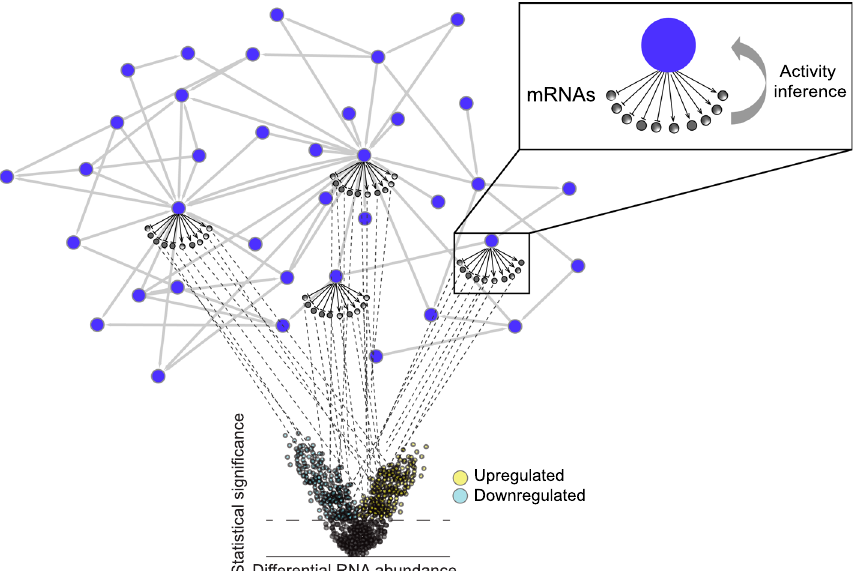
Figure 1. Node scoring with transcriptomic data. In addition to the backbone layer, which describes the molecular pathways involved in each biological process, the network models have a second layer, which harbours information about mRNA regulated by some of the entities in the model backbone (inset above). The activity of the nodes in the model backbone is inferred on the basis of the concordance of transcriptomic changes in the data with the mRNA nodes underneath the backbone nodes. The figure was created using Cytoscape v3.7.1 (https:// cytos cape. org). The Cytoscape graph was then exported to pdf and the layout was further modified for better readability in Adobe Illustrator 2019 (https:// adobe.